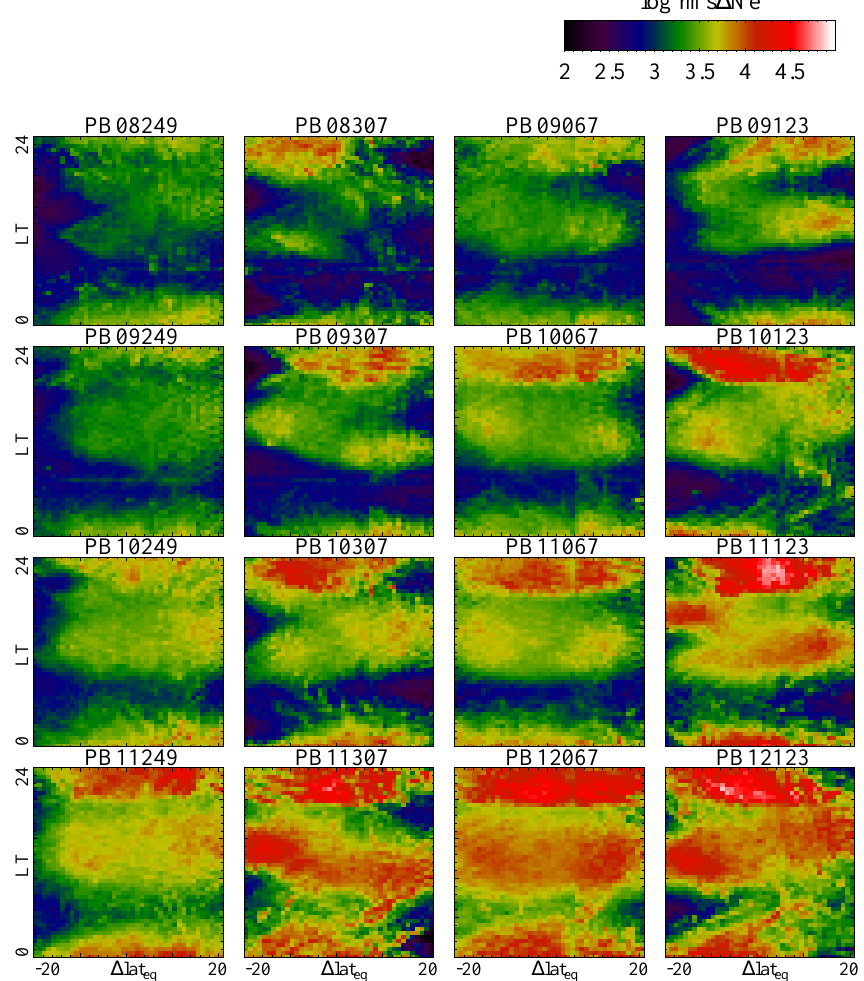
Fig. 9. Climatology of plasma density irregularities as a function of latitudinal distance from the geomagnetic equator and local time (LT), integrated over all longitudes and averaged over seasons from (Northern Hemisphere) summer 2008 (upper left) to spring equinox 2012 (lower right). The density scale is logarithmic, ranging from 10 2 to 10 5 cm − 3 for the density